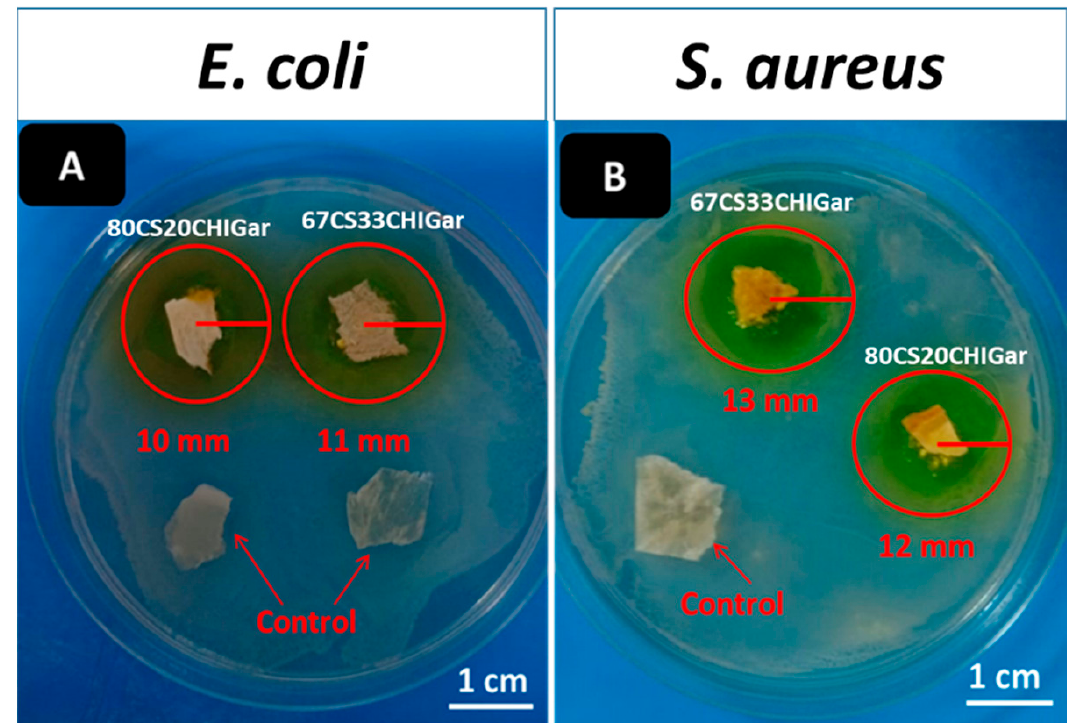
Figure 4. Inhibition zone around both hydrogels ( A ) E. coli and ( B ) S. aureus.